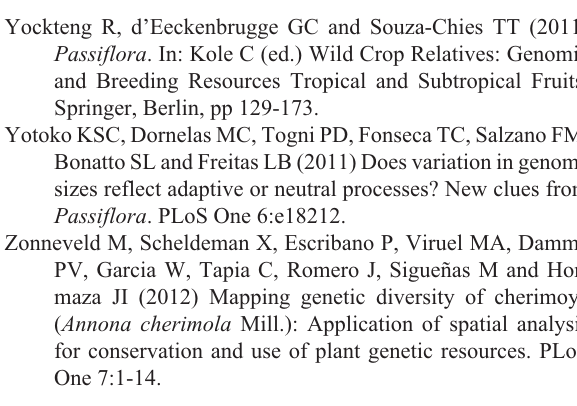
Figure S1 - State of Rio Grande do Sul in the context